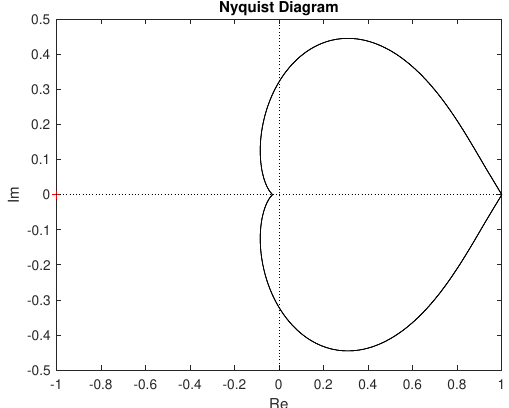
Figure 4. Nyquist diagram of Example 1.